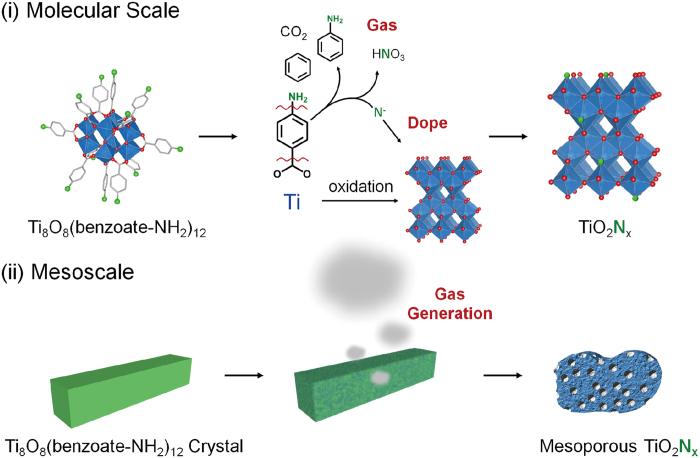
Schematic illustration of the reaction mechanism.Reaction scheme at (i) molecular scale and (ii) mesoscale: Coordination cluster of 1 is converted to mesoporous N-doped TiO2.